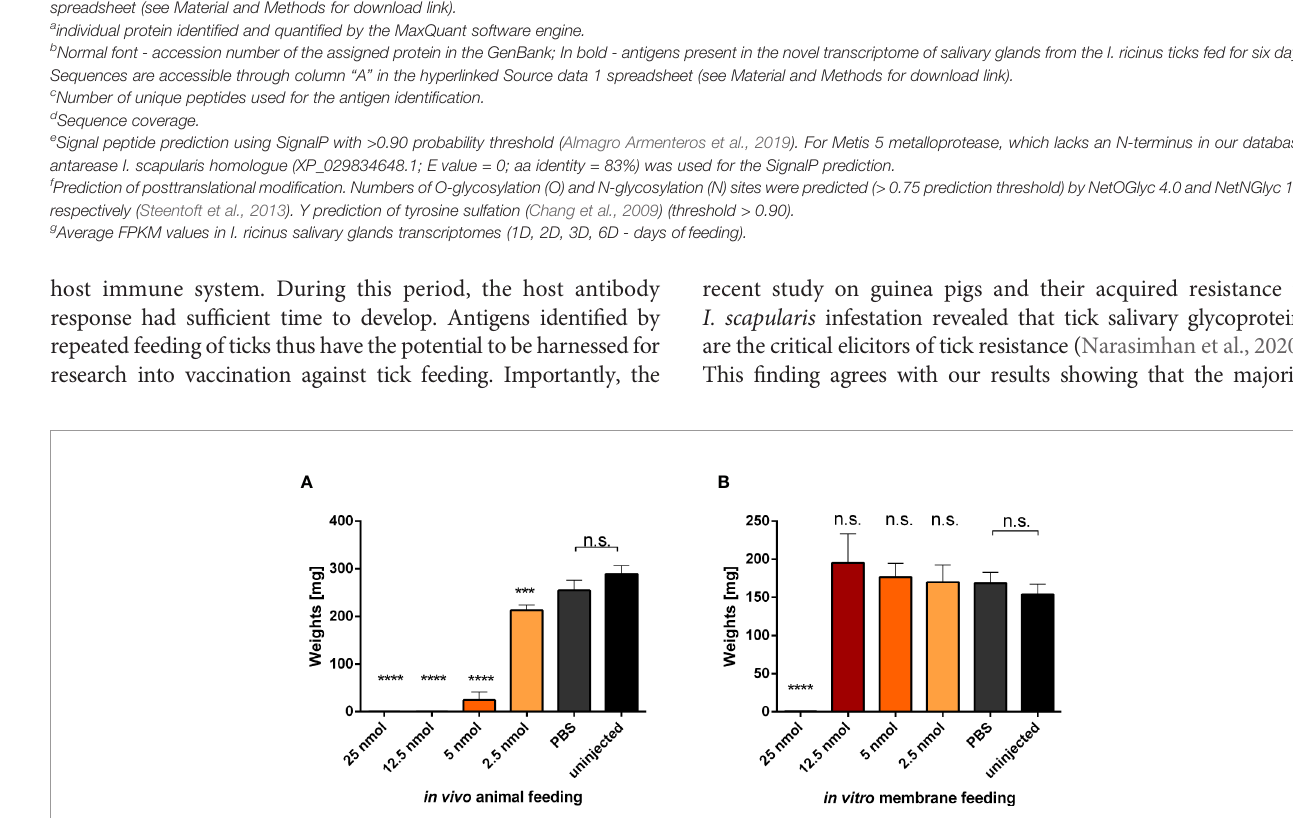
Legend to the Table 1 : Counts of assigned peptides to an individual protein were identi fi ed and quanti fi ed by the MaxQuant software engine. Proteins with a minimum offour assigned uniquepeptidesandwithzeroassignmentinthenaïvesampleareshowninthetable.Onlysequencecoveragesofmorethan2%andQvalues(representingtheprobabilitythattheprotein is a false hit) that equal zero are shown. Full proteomics assignment data are shown in the excel spreadsheet available as Supplementary Data File . Antigens present in the novel transcriptome of salivary glands from the I. ricinus ticks fed for six days are shown in bold, and their sequences are accessible through column “ A ” in the hyperlinked Source data 1 spreadsheet (see Material and Methods for download link). a individual protein identi fi ed and quanti fi ed by the MaxQuant software engine. b Normal font - accession number of the assigned protein in the GenBank; In bold - antigens present in the novel transcriptome of salivary glands from the I. ricinus ticks fed for six days. Sequences are accessible through column “ A ” in the hyperlinked Source data 1 spreadsheet (see Material and Methods for download link). c Number of unique peptides used for the antigen identi fi cation. d Sequence